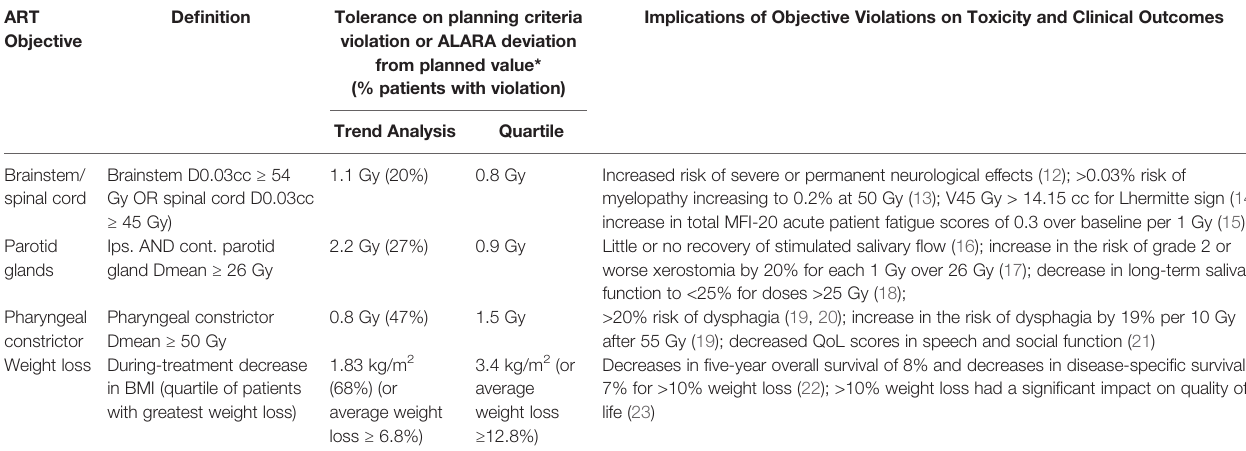
TABLE 3 | Objectives, normal/violation deviation tolerances, and potential clinical implications of